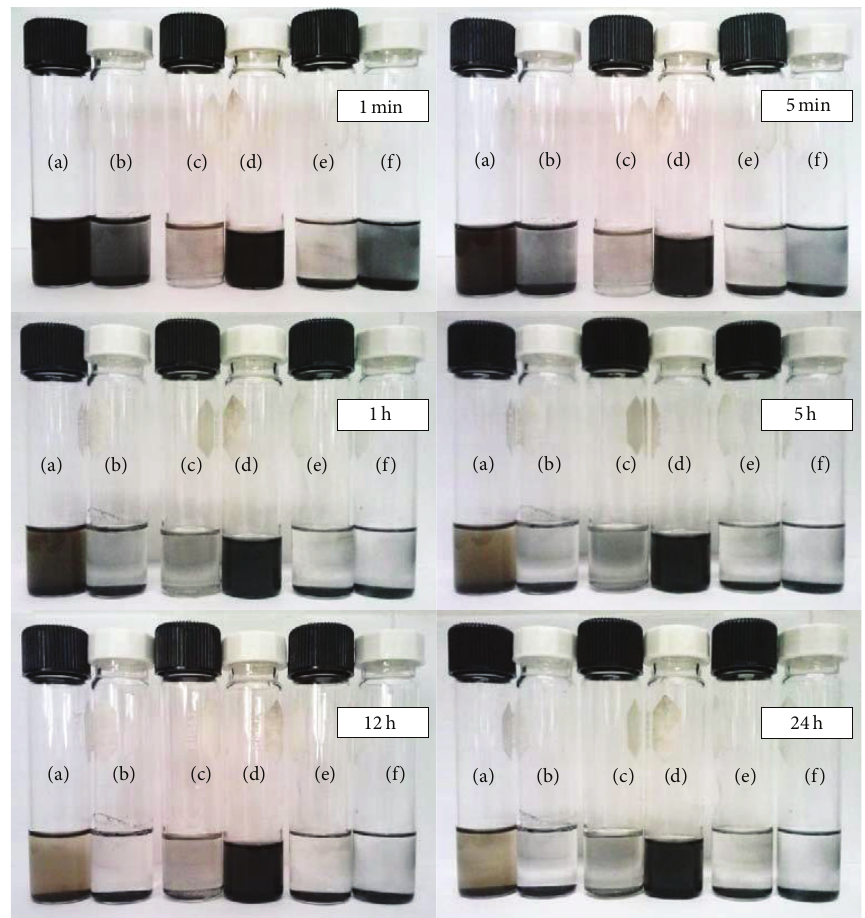
Figure 3: Samples of GO dissolved in water (a), DGEBA (c), and hexane (e) and RGO dissolved in water (b), DGEBA (d), and hexane (f) at different time